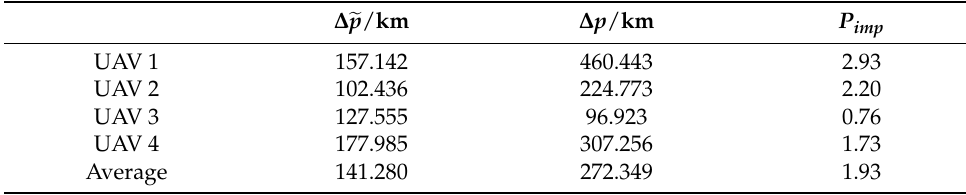
Table 3. Improvement in positioning accuracy of NNA.